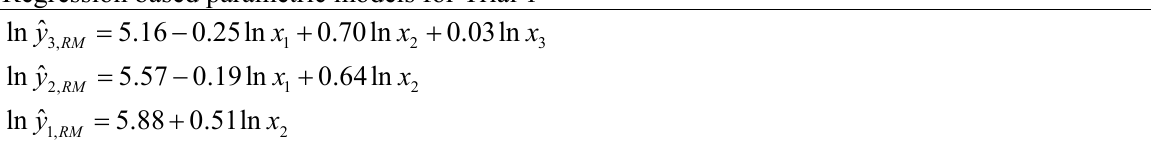
Regression based parametric models for Trial